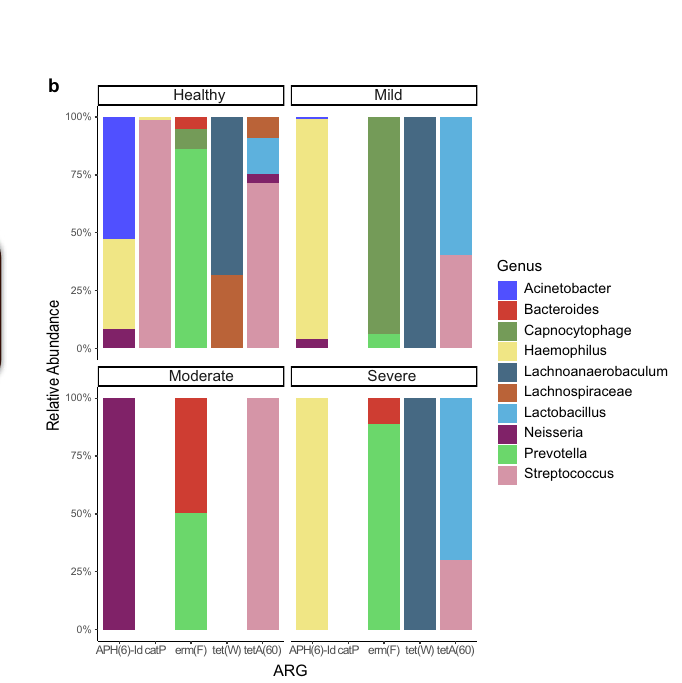
Fig. 7 | The resistome in health and caries. a Differential abundance analysis identi fi ed ARGs that were signi fi cantly abundant in health versus mild caries (green), health versus moderate caries (yellow), and health versus severe caries (red). b Depicts the top 10 bacterial genera associated with ARGs identi fi ed as